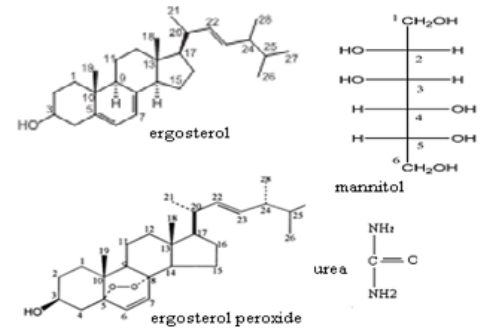
Fig.4. Structures of the compounds from A.silvaticus Ergosterol is also used as an indicator of fungal biomass in soil. Though ergosterol does degrade over time, if kept below freezing in a dark environment, this degradation can be slowed or even stopped completely. Research has shown ergosterol may have antitumor properties